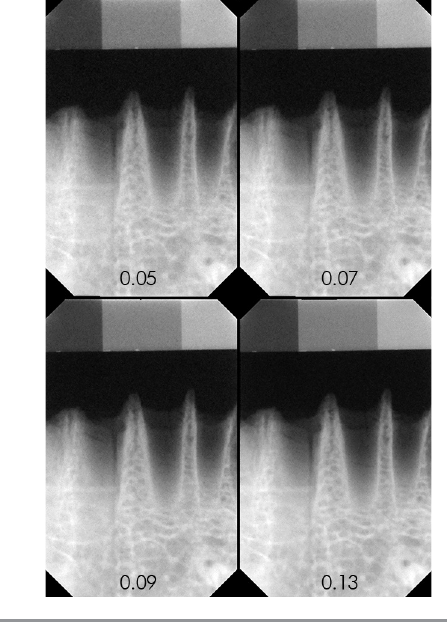
Figure 1. Images of the different groups.